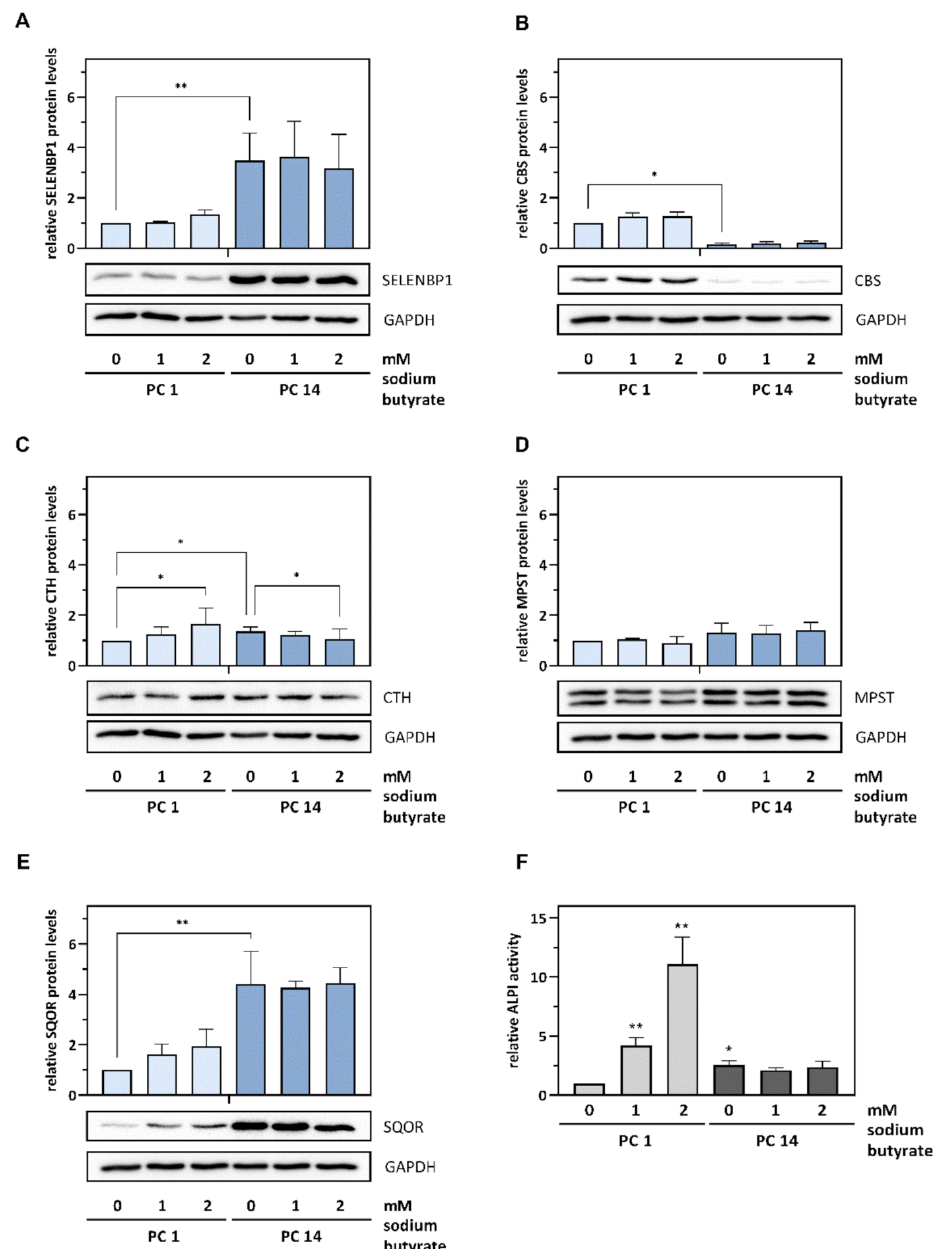
Figure 4. Spontaneous and butyrate-induced differentiation affect the protein levels of H 2 S- modulating enzymes in Caco-2 cells in a partially divergent manner. Proliferating and spontaneously differentiated cells were treated with sodium butyrate for 72 h until either day 1 (PC 1) or day 14 (PC 14) of differentiation. ( A – E ) Relative protein levels of SELENBP1, CBS, CTH, MPST and SQOR, respectively, in cell lysates were determined by immunoblotting and densitometric analysis of the blots, with normalization against Ponceau S-stained protein bands (the untreated control at PC 1 was set as reference). Three independent experiments were performed; the data represent means ± SD (upper panels). Representative immunoblots, with corresponding detection of the housekeeping protein GAPDH after membrane stripping, are shown (lower panels). ( F ) The relative enzymatic activity of ALPI in the lysates (the untreated control at PC 1 was set as reference) was measured photometrically to monitor differentiation. Statistical analysis was done using the Friedman test and Dunn’s post-hoc test, with statistical significance at p < 0.05 (*) and p < 0.01